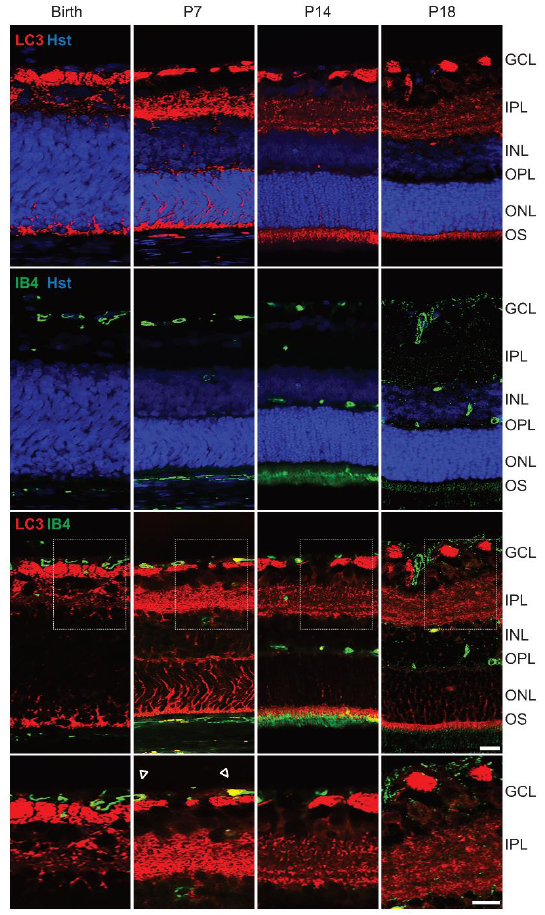
Figure 5. Expression pattern of LC3 in the developing rat retina. Representative immunohistofluo- rescence analysis of LC3 (red) and isolectin B4 (IB4; green) and Hoechst (Hst; blue) in retina sections of rat pups at birth, P7, P14 and P18. Dashed squares indicate the magnification area of GCL and IPL layers. Arrows represent colocalization of LC3 with IB4 in retinal vasculature. GCL, ganglion cell layer; IPL, inner plexiform layer; INL, inner nuclear layer; OPL, outer plexiform layer; ONL, outer nuclear layer; OS, outer segments of photoreceptors. Scale bar = 50 μm.